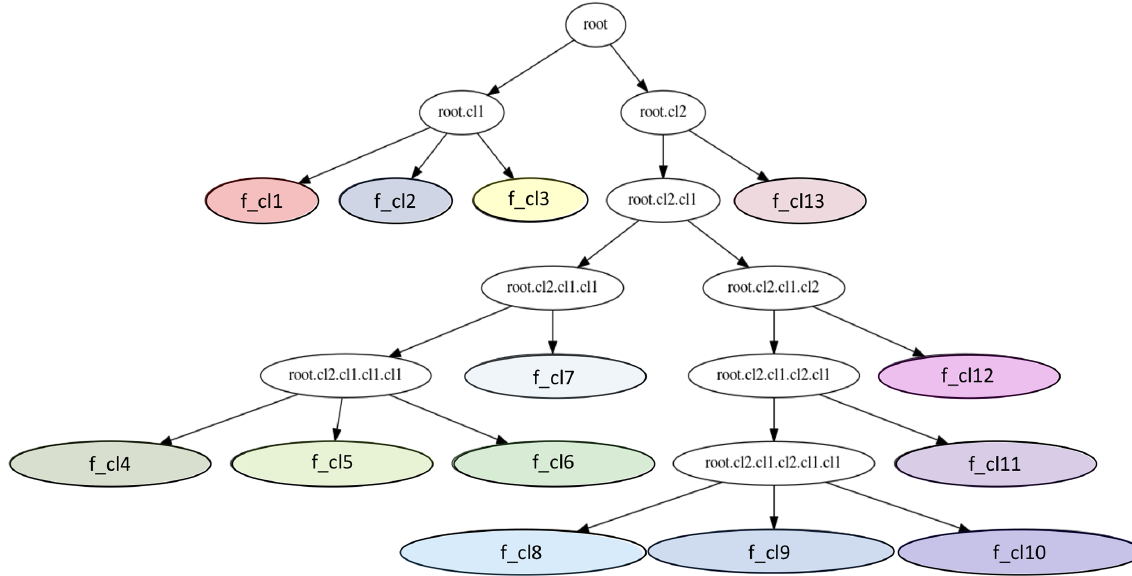
Figure 5. Final hierarchical structure of the optimal clustering found for the QVP input data described in Table 1. The final set of optimal clusters consists of coloured clusters f_cl1, f_cl2, ... , f_cl13.